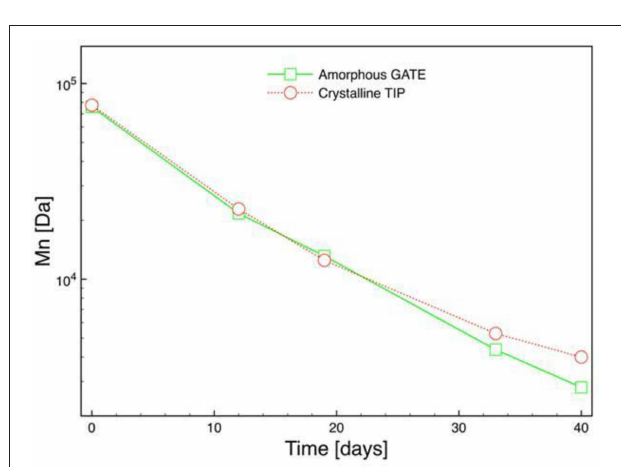
FIGURE 8 | DSC curves of amorphous zone of biphasic samples at different time of degradation.